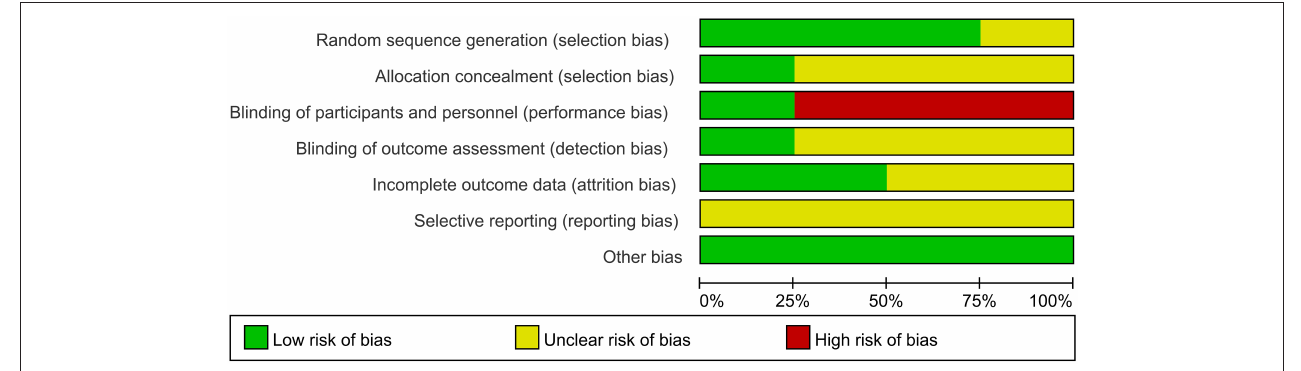
FIGURE 2 | Risk of bias